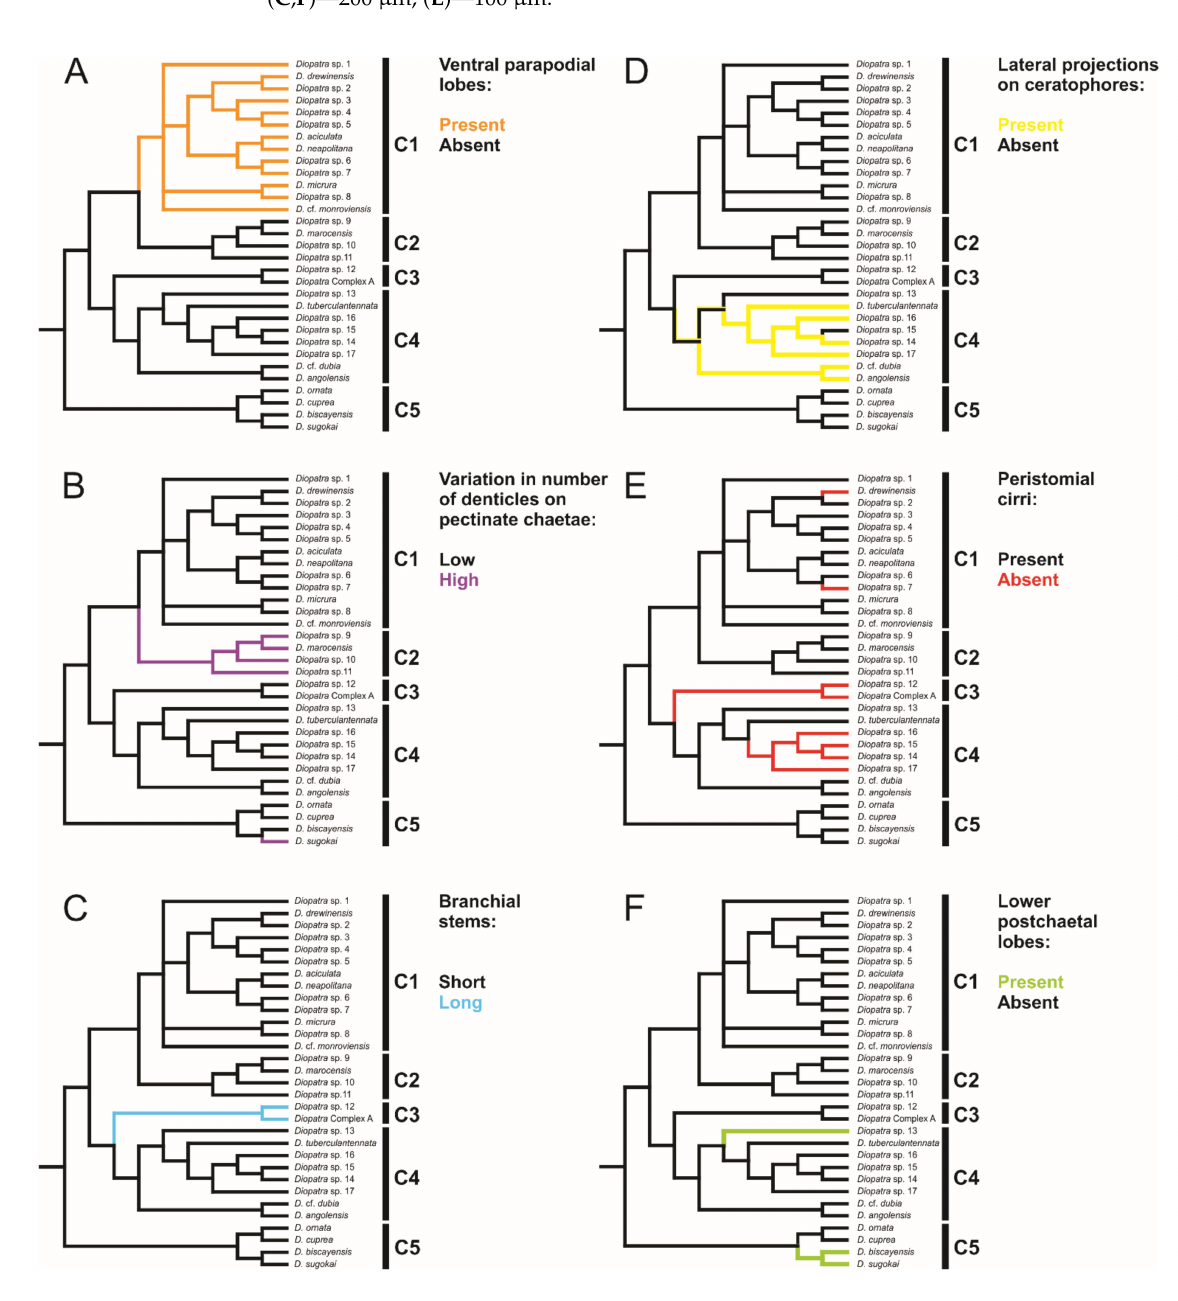
Figure 6. Optimization of six morphological characters described in Table 1 on Diopatra species